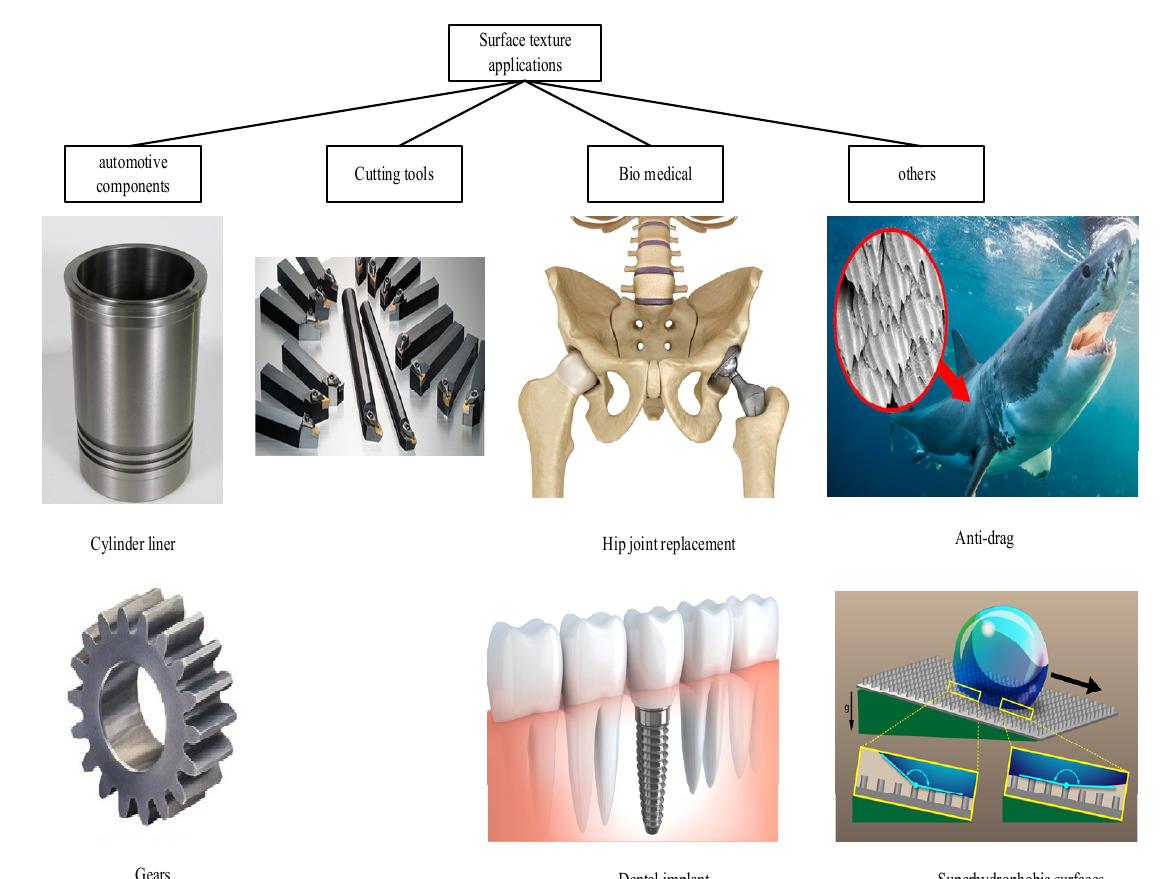
Figure 12. Application of surface texturing.